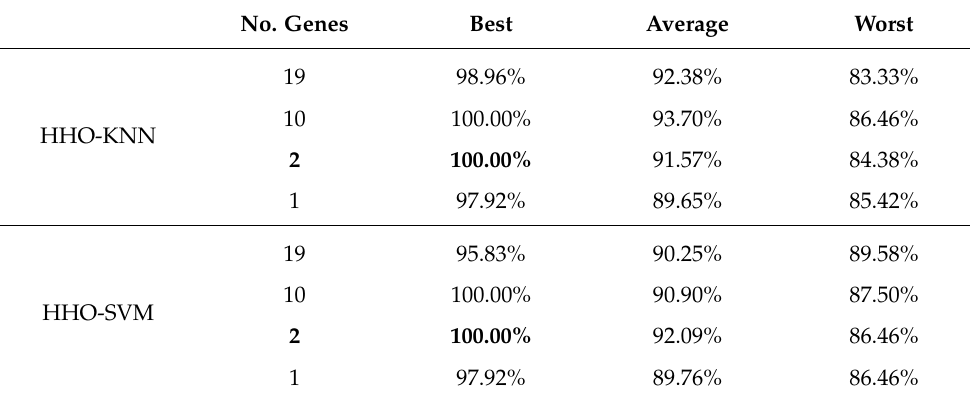
Table 6. Lung data set results.